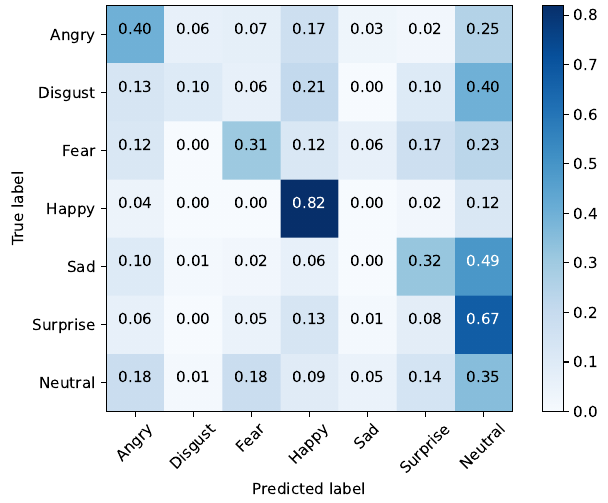
Figure 8. Baseline testing set (SFEW).